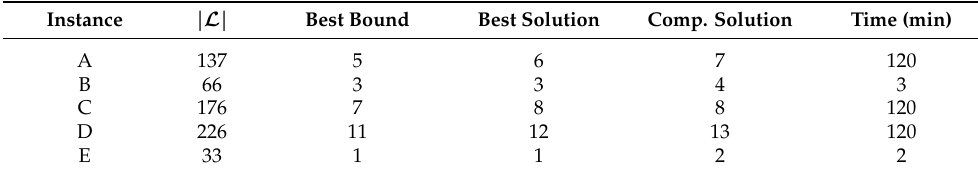
Table 7. Average of computational results.